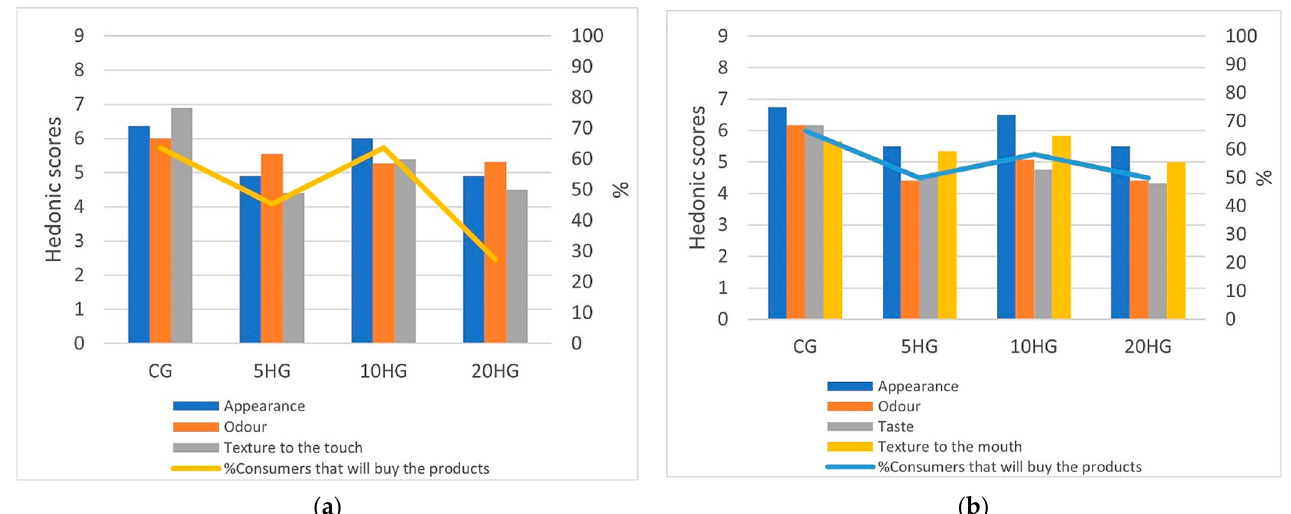
Figure 2. Combo chart representation of the hedonic consumer test for control and hemp seed flour-enriched gnocchi samples: ( a ) raw samples; ( b ) cooked samples.